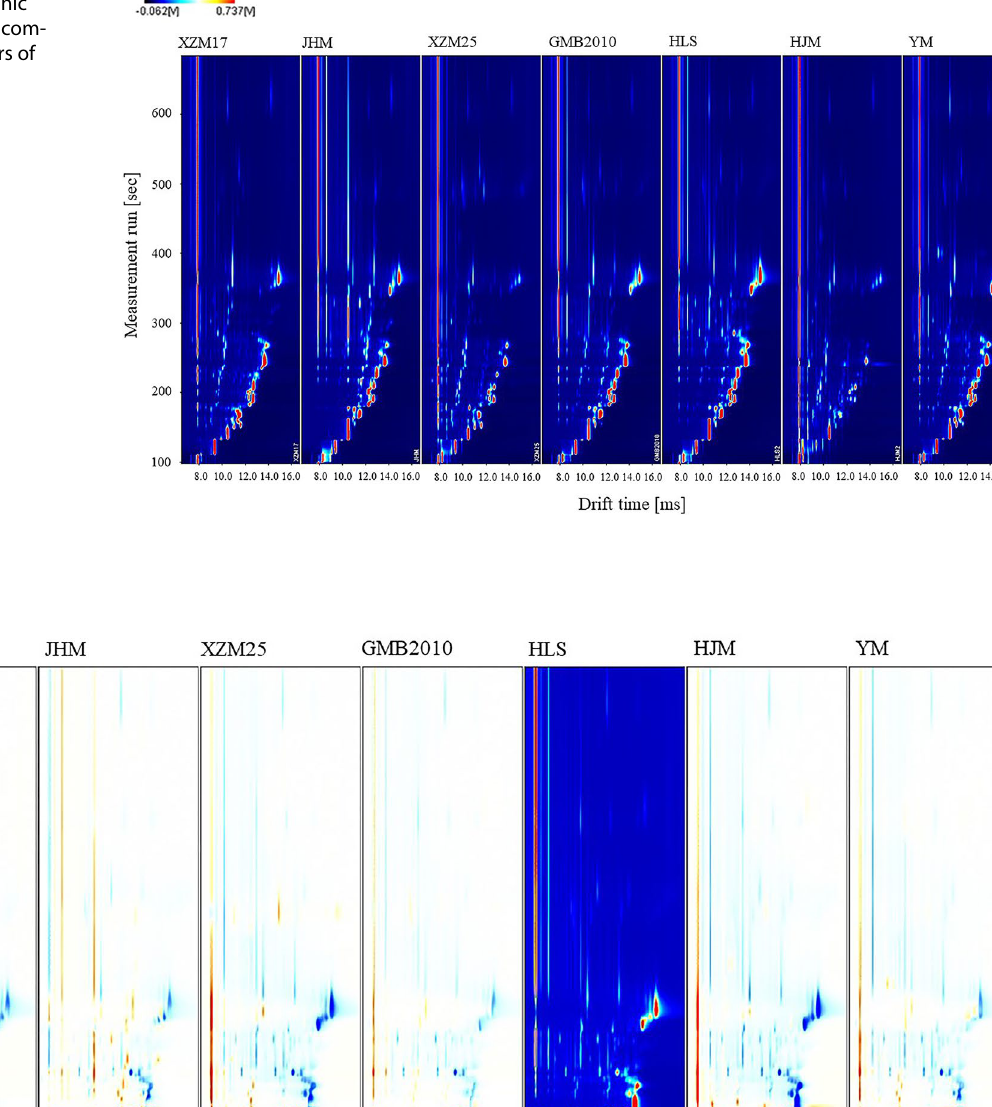
Fig. 2 GC-IMS topographic plots of volatile organic com- pounds in seven cultivars of melons